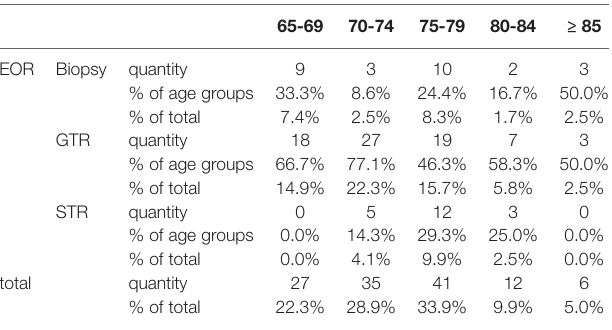
TABLE 1 | EOR according to different age groups.